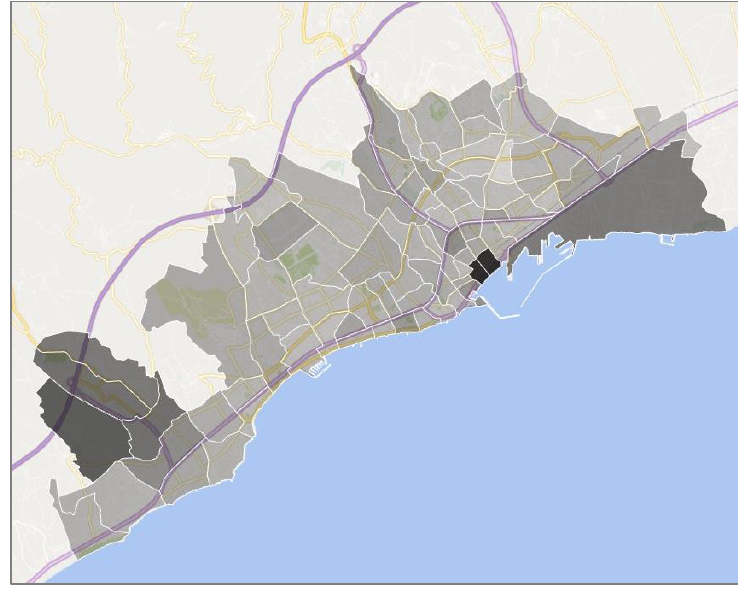
Figure 2 Accident per population by neighborhood (accidents at local streets only) Source: from Ministry of Interior. General Directorate of Security. Prepared in MS Excel